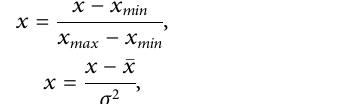
Frontiers in Energy Research |